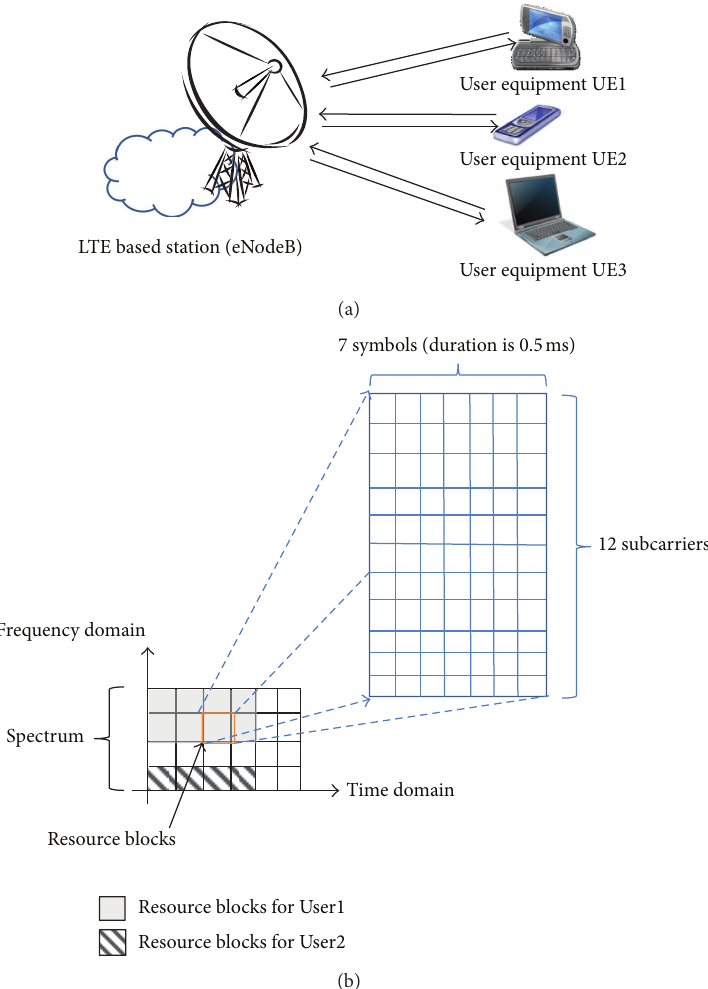
Figure 1: Illustration of services controlled and resources allocated by an LTE based station (eNodeB) in the LTE network. (a) UE with differential QoS requirements of services and (b) resource blocks allocated for a UE by a eNodeB in the frequency domain and time